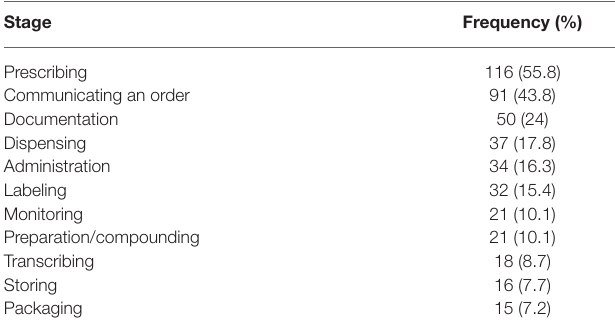
TABLE 5 | Stage of the medication management process, at which MEs mentioned and their